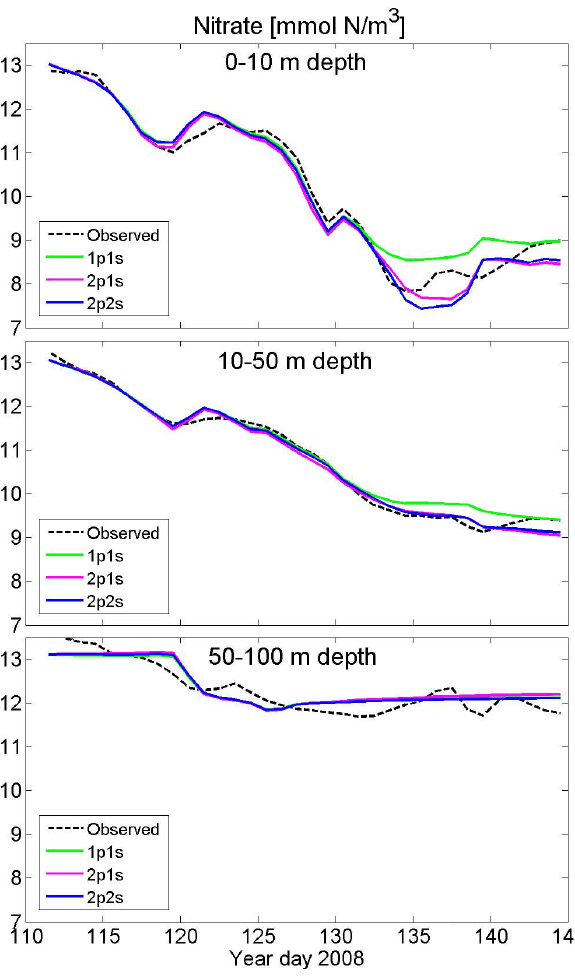
Fig. 6. Observed and simulated mean DIN concentrations for dif- ferent depth intervals.